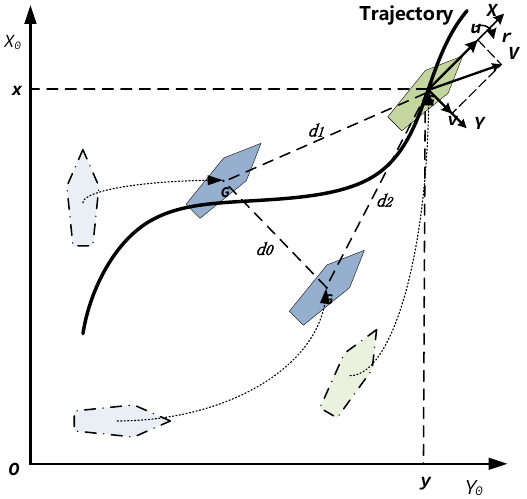
Figure 1. Earth-fixed and body-fixed coordinate frames of